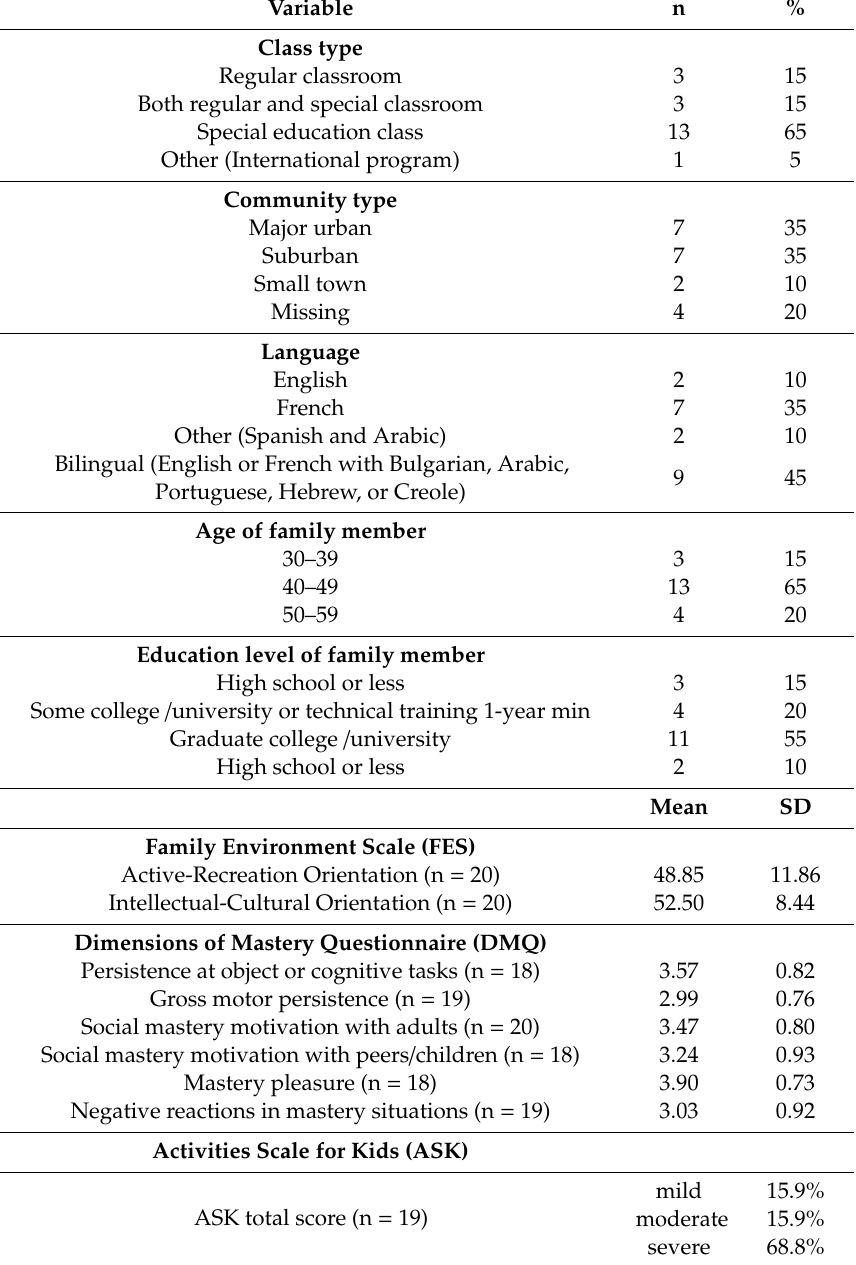
Table 1. Sample Characteristics (n =